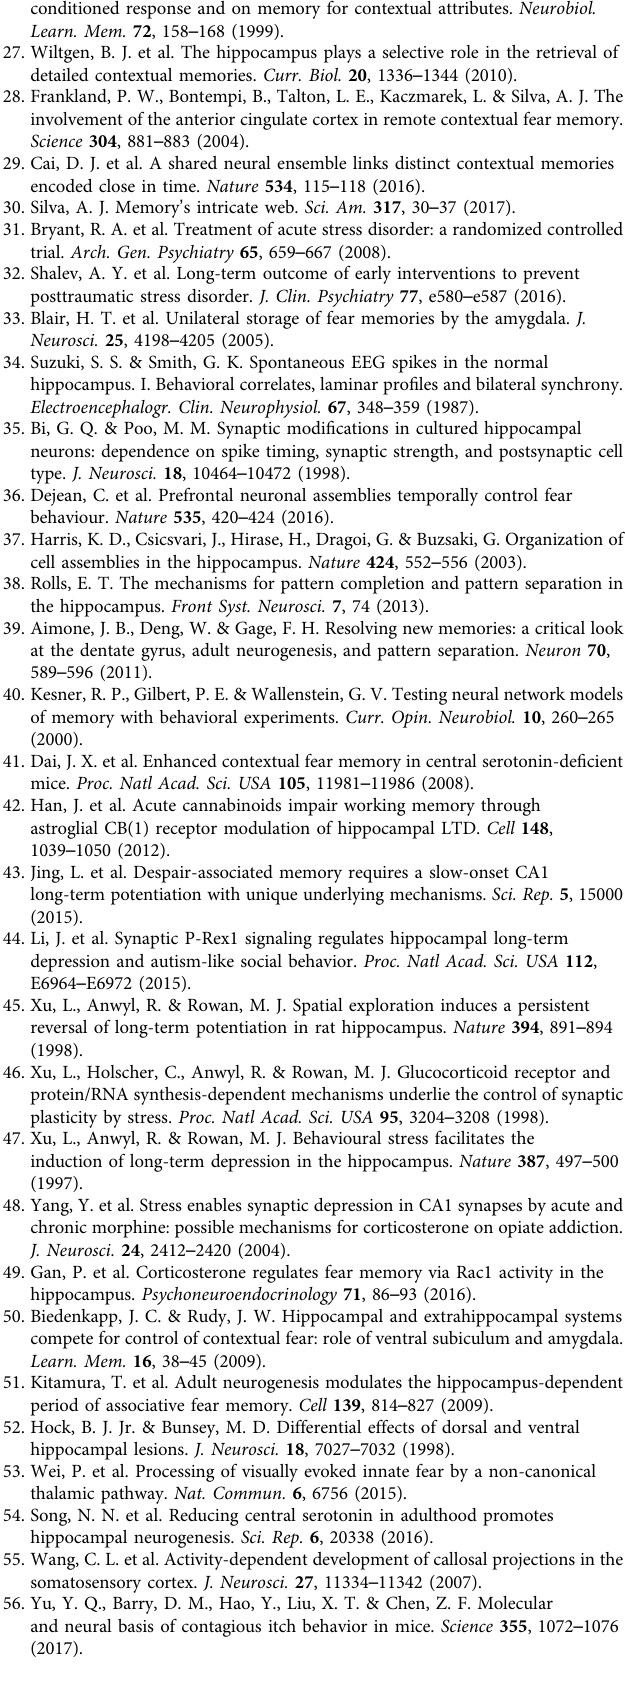
for control vs. treatment, and between treatments, or contrast effects for T-box vs. G-box. The signi fi cance level was set at P <